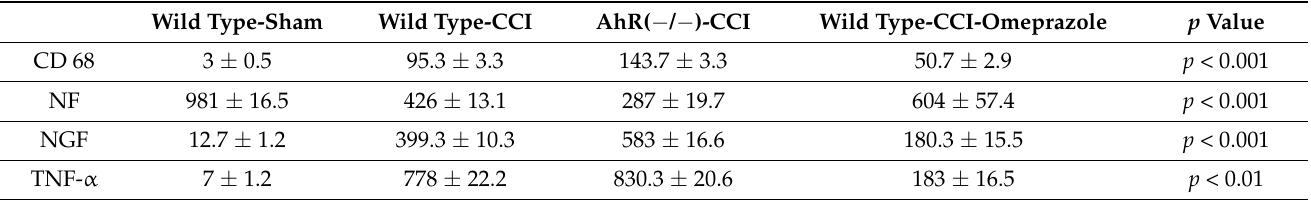
Table 2. Expression of regeneration and associated proteins in the distal end of neve.